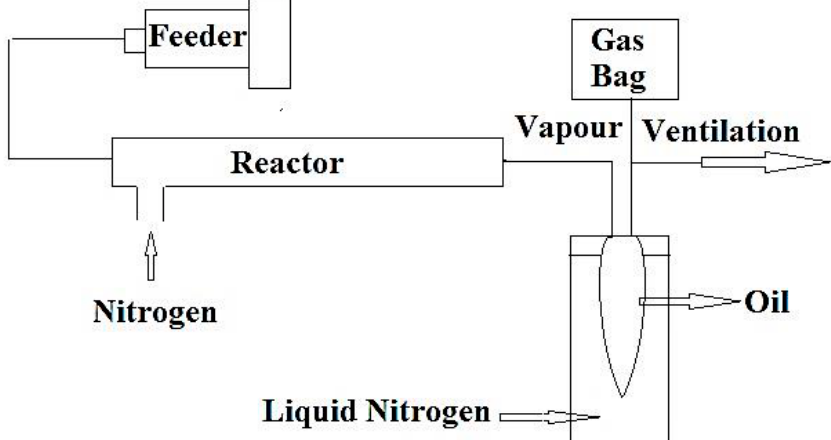
Figure 2. Schematic diagram of the experimental apparatus for cracking of raw plastic pyrolysis oil and extracted oil after separation of aromatics (adapted from Reference [36]).